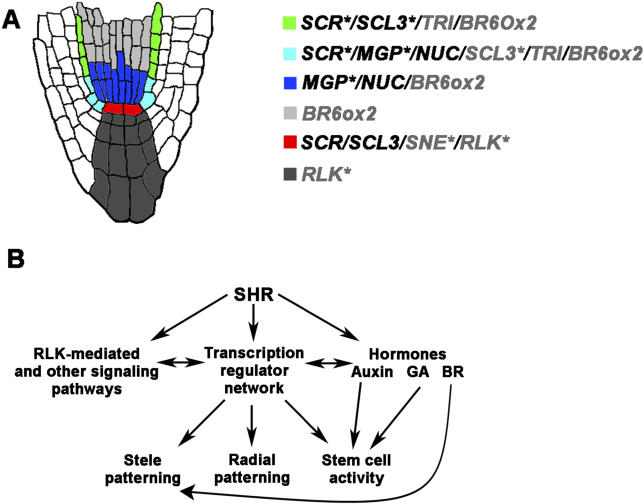
Models for SHR Function in Root Development(A) The interaction of SHR with various coregulators allows for the activation of specific direct targets defining five functional subdomains in the SHR domain: the QC, the early endodermis, the late endodermis, the early stele, and the late stele. The spatial specificity of the different direct targets allows SHR to function in QC specification, CEI asymmetric cell division, early and late endodermal specification, but also early and late stele specification. The gene name was indicated in black or in gray when the expression was inferred from RNA in situ hybridization or digital in situ data, respectively. The stars indicate genes for which binding to the promoter region was demonstrated by ChIP-QRT-PCR.(B) Global model of the SHR developmental pathway. SHR controls root development through the regulation of three interconnected modules: a transcription regulator module, a hormonal module, and a signaling module. The interactions between these three modules determine the developmental output of the pathway on stem cell niche specification, radial patterning, and stele development.